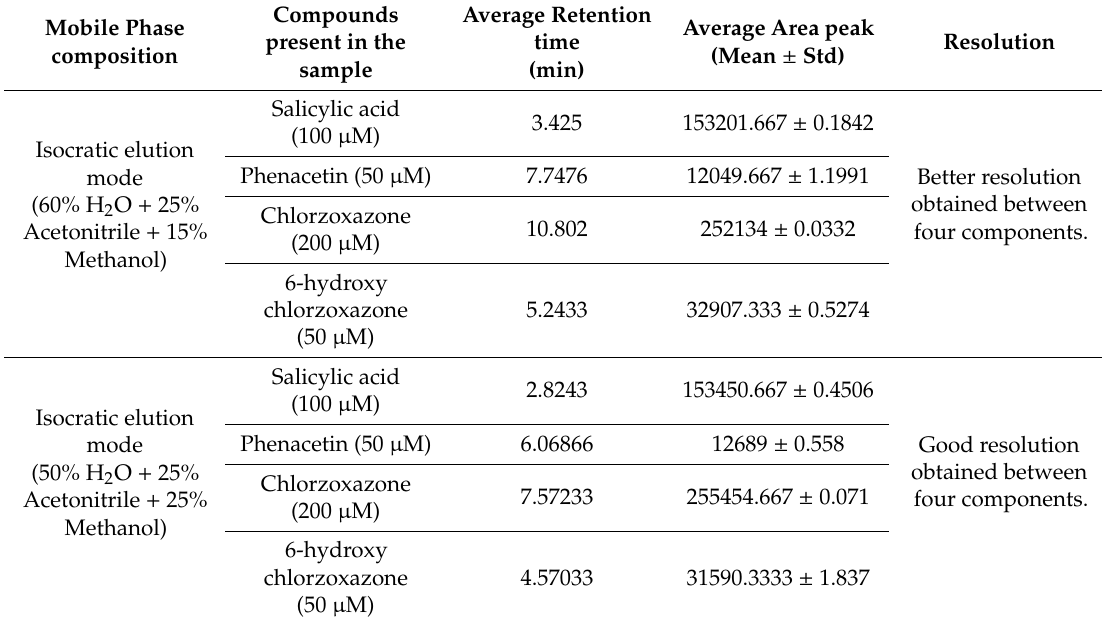
Table A1. Variation in retention time, and resolution between compounds when changing the composition of mobile